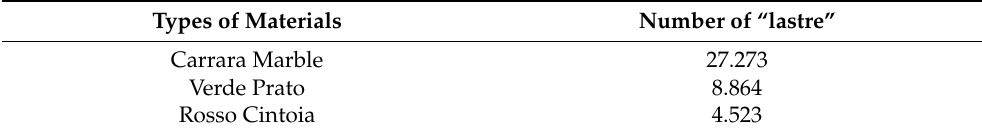
Table 3. Types of materials of the Campanile di Giotto and number of